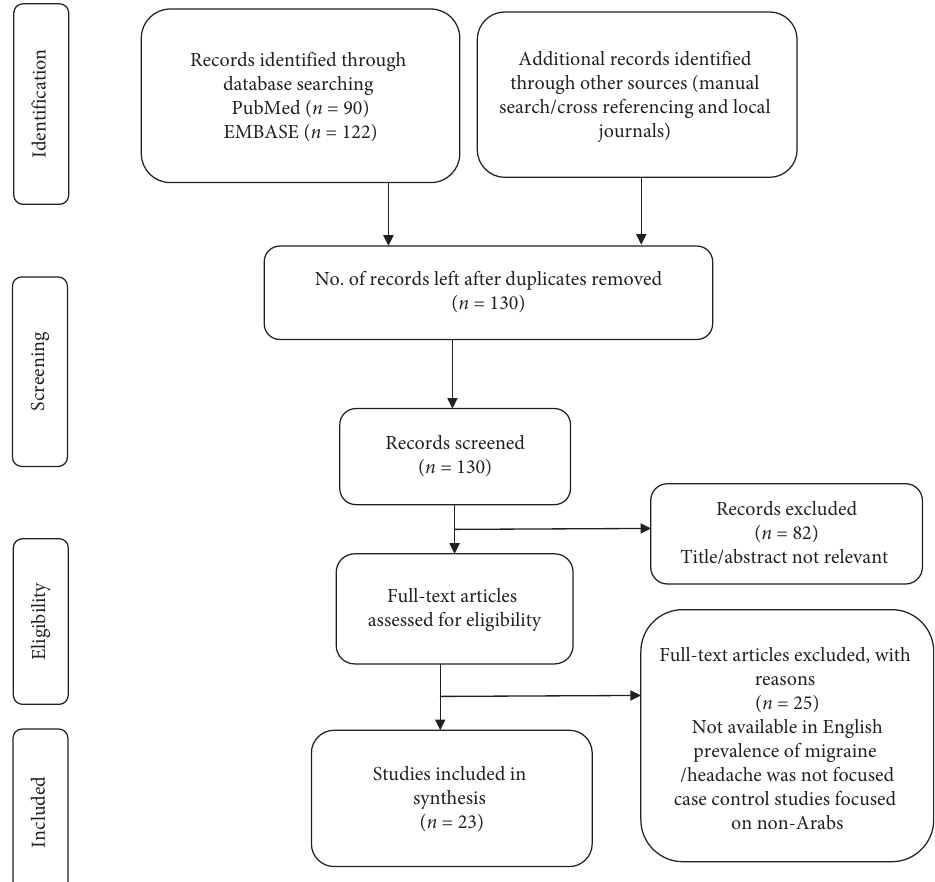
Figure 1: Flow diagram of the included